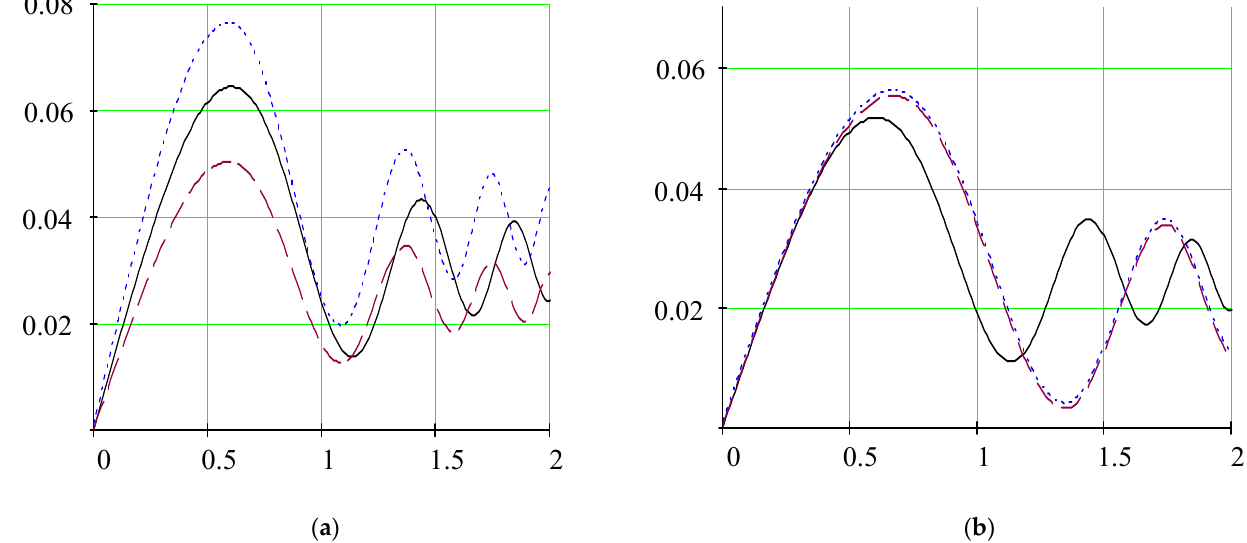
Figure 3. Change in the amplitude of bending vibrations during the transition through internal resonance at different values of the amplitude of longitudinal vibrations ( a ) (- - - b = 0.0015 m, – – – b = 0.001 m, —— b = 0.0125 m); and different speeds of motion CFHM ( b ) (- - - V = 1 m/s, – – – V = 1.25 m/s, —— V = 5 m/s).